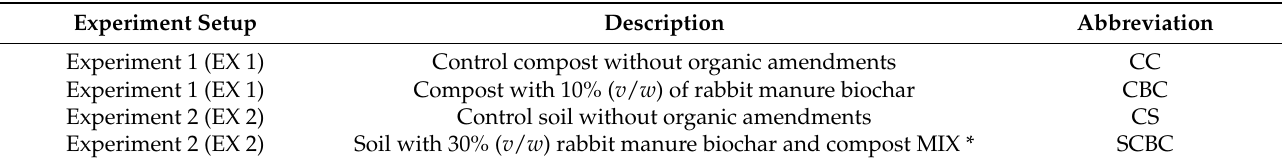
Table 3. Summary of the treatments in greenhouse